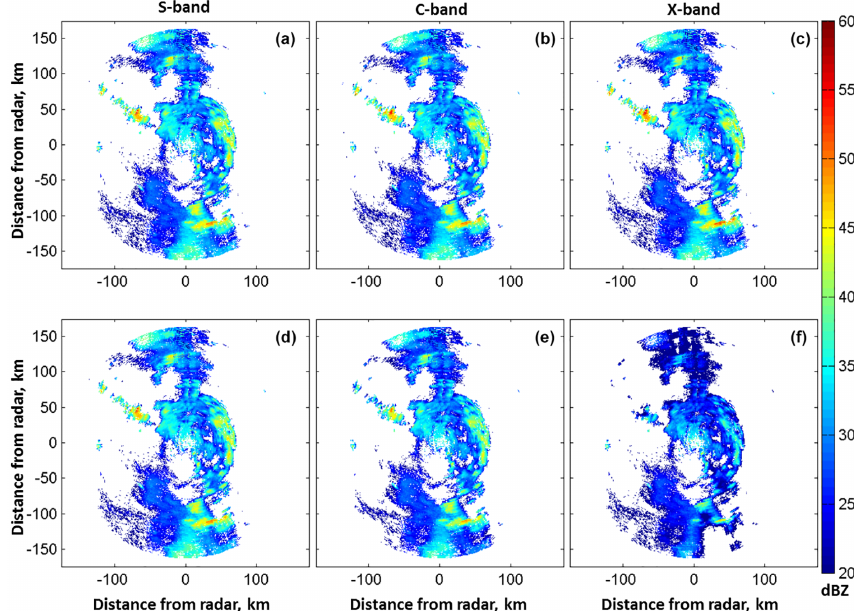
Figure 3. Panels (a, b, c) indicate the reflectivity without attenuation simulated from DSD for S-, C-, and X-band polarimetric radar, respectively, on 17 September 1998, 22:11UTC. Panels (d, e, f) indicate the measured reflectivity with attenuation effect for S-, C-, and X-band polarimetric radar, respectively. The radar is located in the center of each panel.